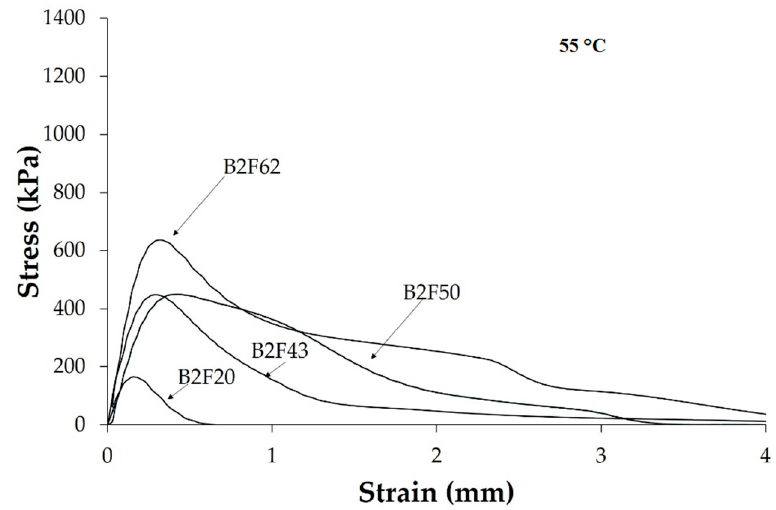
◦ C of some EBA copolymer + ECH resin Figure 14. Stress vs. strain curves at 55 °C of some EBA copolymer + ECH resin blends. Figure 14. Stress vs. strain curves at 55